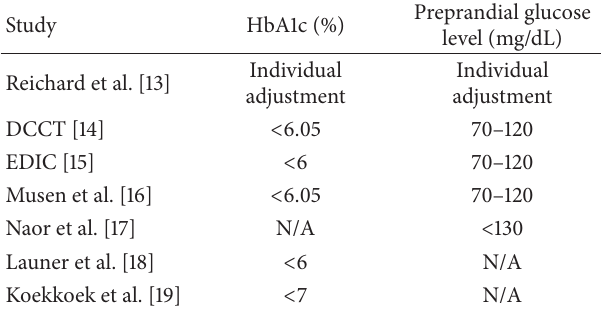
Table 1: Treatment goals for the definition of intensive glucose